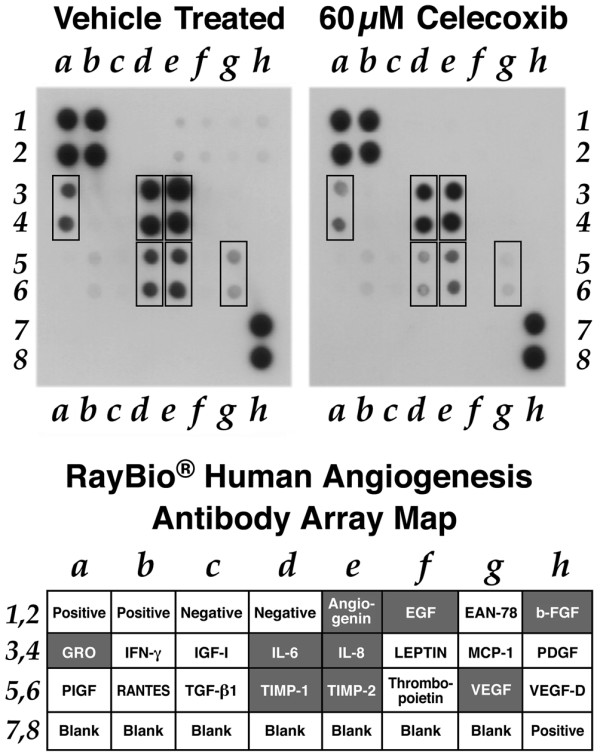
Cell supernatant analysis of angiogenic proteins revealed decreased levels with celecoxib treatment. The cell culture supernatants from MDA-MB-231 cells treated with vehicle and 40 mmol/l celecoxib for 24 hours were tested on a human angiogenesis protein array. The cell culture supernatants of cells treated with vehicle had higher amounts of GRO, IL-6, IL-8, TIMP1, TIMP2, and VEGF based on gray levels or brightness values as compared with cells treated with celecoxib. Other proteins affected by treatment were EGF, bFGF, and angiogenin. The array template is shown in the lower panel, with dark gray indicating high expression. bFGF, basic fibroblast growth factor; EGF, epidermal growth factor; IFN, interferon; IGF, insulin-like growth factor; IL, interleukin; MCP, monocyte chemoattractant protein; PDGF, platelet-derived growth factor; PG, prostaglandin; RANTES, regulated on activation, normal T cell expressed and secreted; TIMP, tissue inhibitor of matrix metalloproteinase; VEGF, vascular endothelial growth factor.